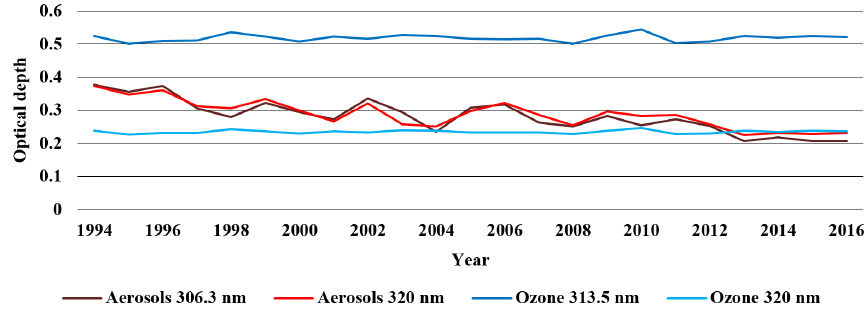
Figure 10. Comparison of values of average annual optical depth for the selected wavelengths for ozone and aerosols, 1994–2016.